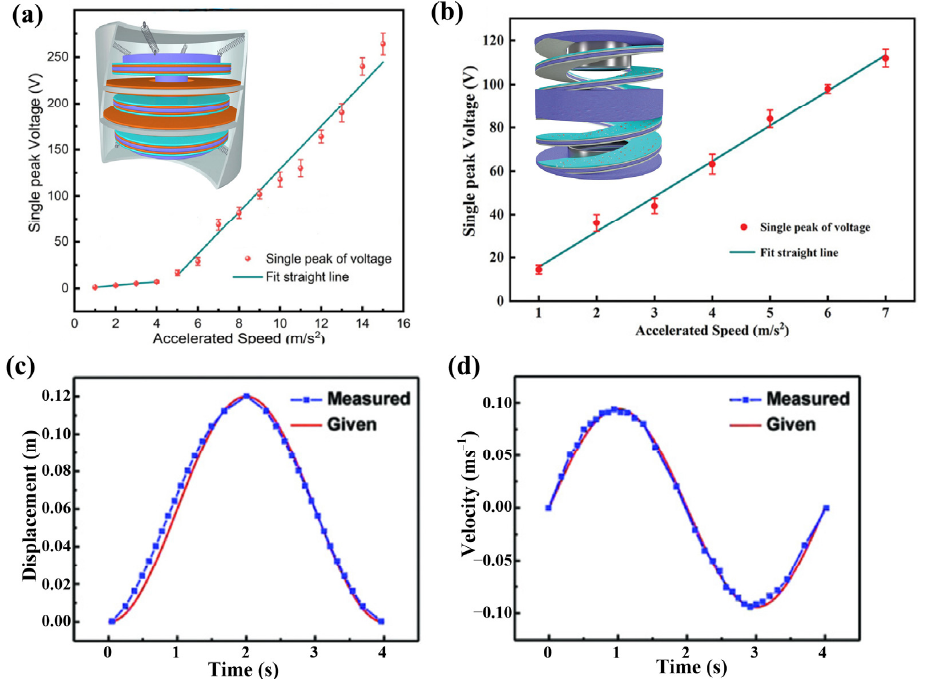
Figure 13. The acceleration-output relationships of ( a ) a multilayer suspension structured acceleration sensor (Reproduced with permission [100]. Copyright 2021 The authors) and ( b ) a double helix acceleration sensor (Reproduced with permission [101]. Copyright 2021 Wiley-VCH GmbH); ( c ) The real-time measured displacement and given displacement; ( d ) The real-time measured velocity and given velocity (Reproduced with permission [51]. Copyright 2018 WILEY-VCH Verlag GmbH & Co., KGaA, Weinheim, Germany).